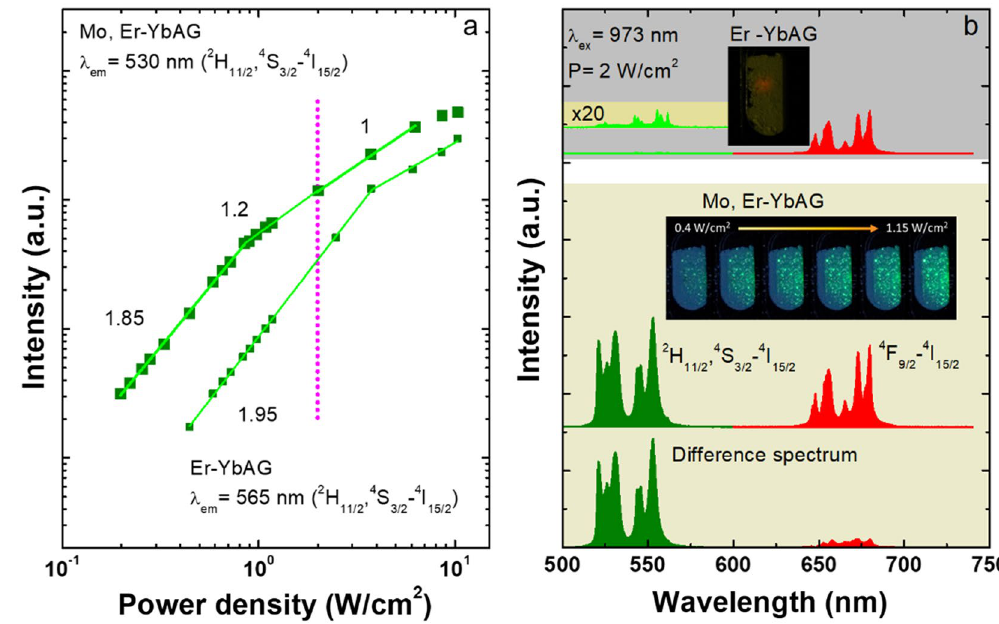
Figure 2. ( a ) Power density dependence of Er upconversion emission in (Mo) Er-YbAG under 973 nm cw excitation. Vertical dotted line corresponds to power density used in experiments (2 W/cm 2 ); ( b ) Comparison between the Er upconversion emission spectra in (Mo)Er-YbAG. Digital photos show a non-uniform distribution of green (Er) bright spots across powder samples contained in a quartz